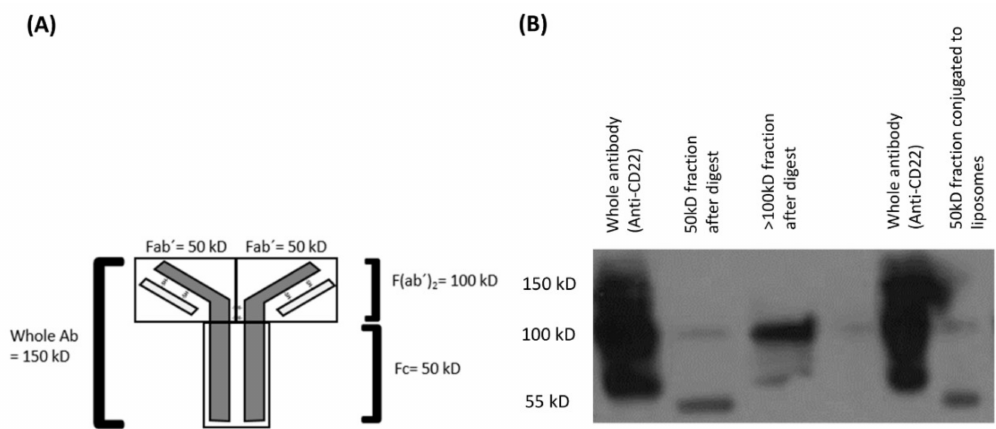
Figure 5. ( A ) Verification of anti-CD22 Fab’ conjugation; ( B ) Verification of conjugation of anti-CD22 Fab’ by western